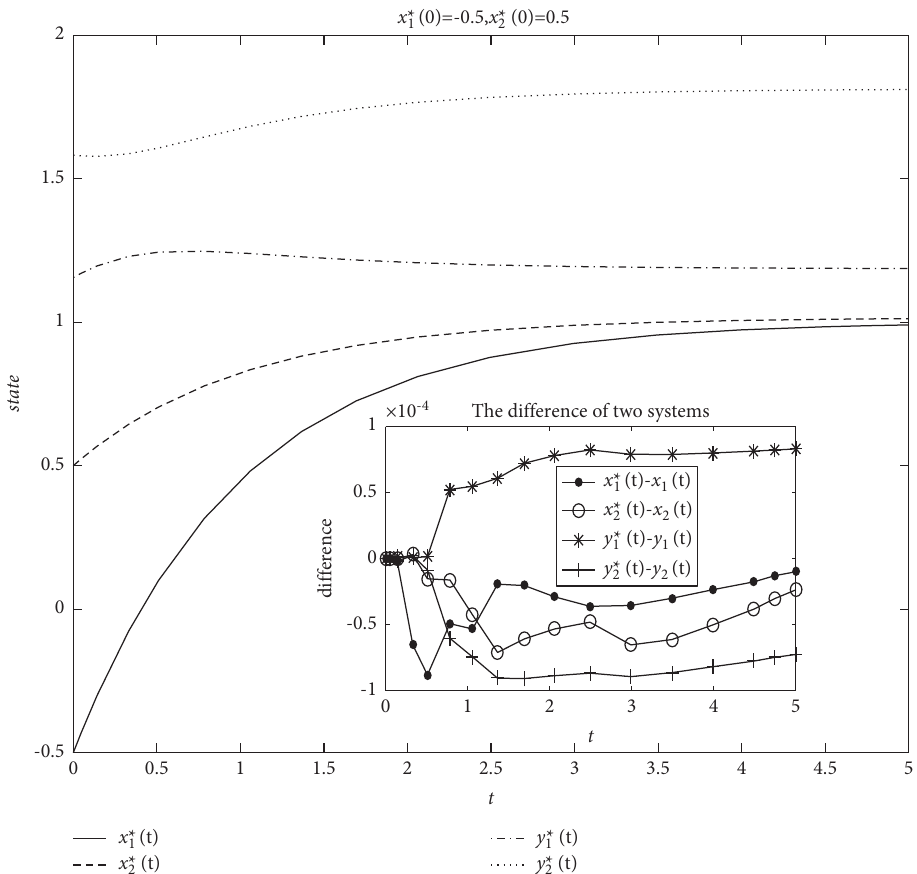
Figure 1: States ( x